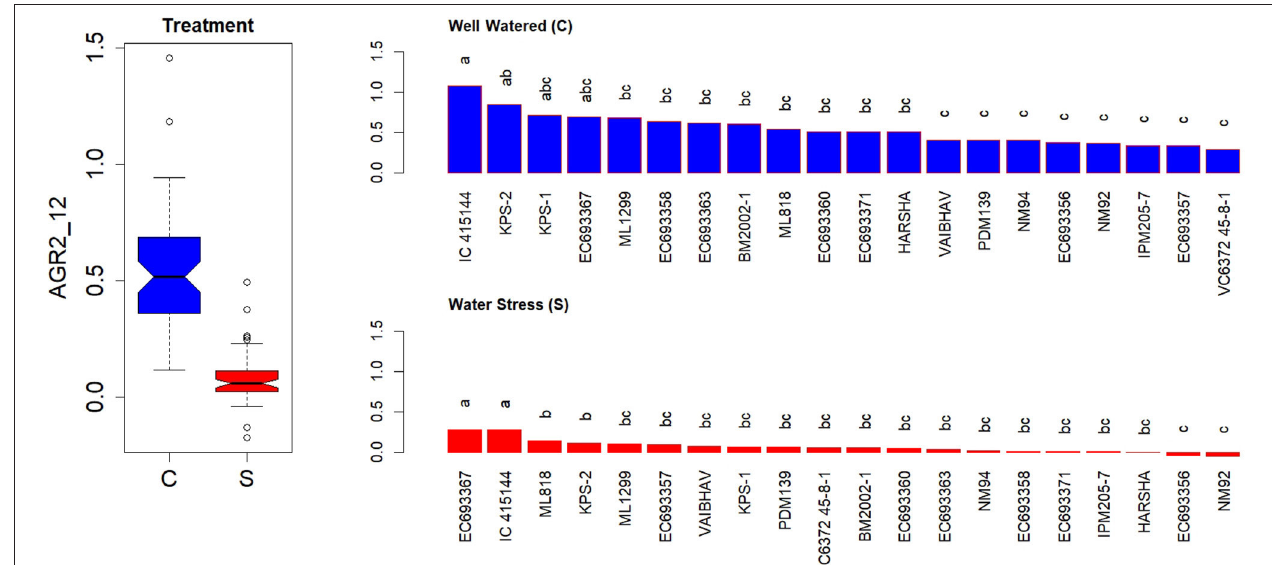
FIGURE 5 | Genetic variation in AGRs during the initial phase in response to two levels in well-watered (C) and water-stressed (S) plants; AGRs were computed for 2–12 days. Each box in the treatment effect represents 60 observations (3 replications and 20 genotypes). Each bar in the genotype effect for each treatment represents mean values of three replications. Letters represent the significance of differences among mean values as computed by the Duncan multiple range test at 0.95 CI. Genotypes with common letters are not significantly different.